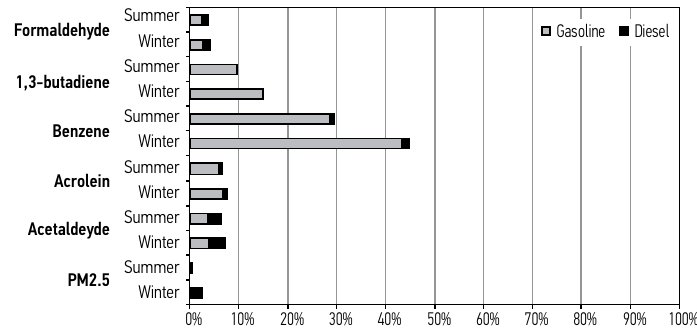
Fig. 7. Contribution of the cold start emission (average values, percentage) to the total emissions within the modelling domain